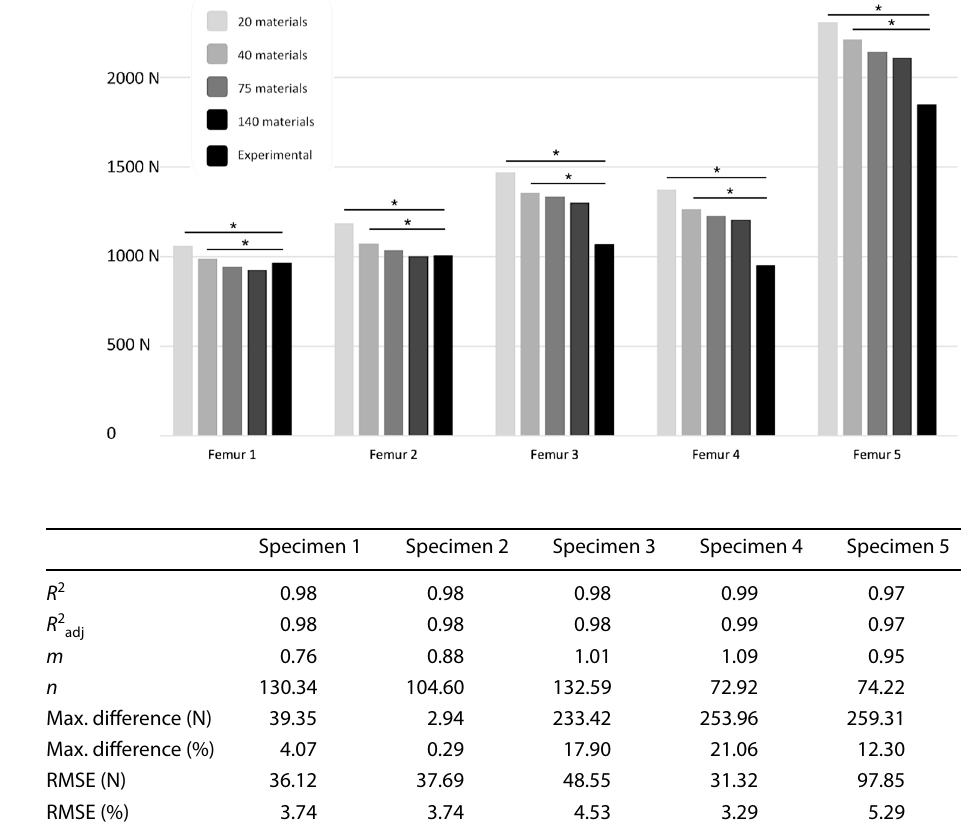
adjusted coefficient of adj